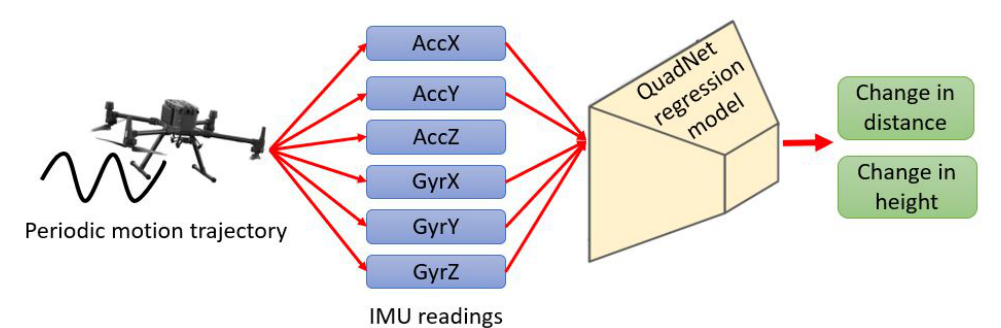
Figure 3. QuadNet’s end-to-end part regresses the change in distance and height using only the inertial sensor